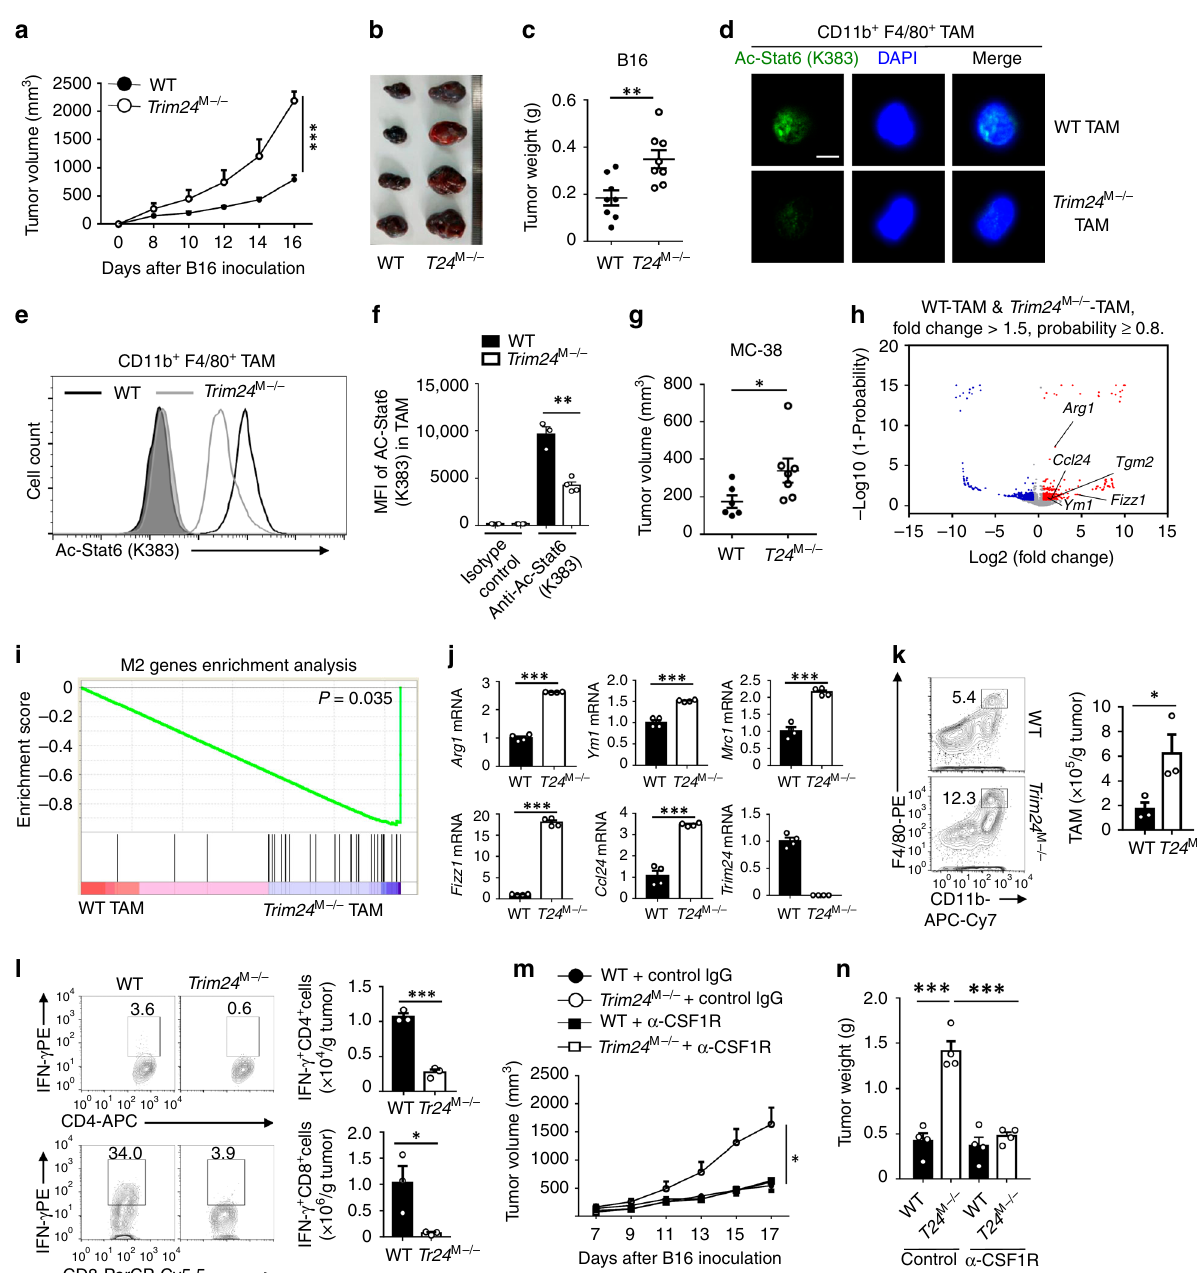
Fig. 7 Trim24 de fi ciency in macrophages impaired antitumor immunity. a – c Tumor growth ( a ), representative tumor pictures ( b ), and tumor weight ( c ) of WT and Trim24 M − / − mice ( n = 8) that were injected s.c. with B16 melanoma cells. d Confocal microscopy images showing Lys383-acetylated Stat6 in the nucleus of tumor-associated macrophages (TAMs) that isolated from B16 melanoma of WT and Trim24 -de fi cient mice; DAPI staining indicated the nucleus of the cells. Scale bars: 5 μ m. e , f Flow cytometric analysis of endogenous Stat6 acetylation at Lys383 in WT and Trim24 -de fi cient TAM as described in ( d ). Data are presented as a representative histogram ( e ) and summary bar graph ( f ). g Tumor weight of WT (n = 6) and Trim24 M − / − mice ( n = 7) that were injected s.c. with MC-38 colon adenocarcinoma cells. h – j RNA-sequencing analysis of gene pro fi les ( h ), M2 gene enrichment ( i ), and QPCR veri fi cation of M2 genes ( j ) in WT and Trim24 M − / − TAM that were isolated from B16 melanoma. The M2 signature genes were indicated in the plot. k , l Flow cytometric analysis of CD45 + CD11b + F4/80 + TAM ( k ) and IFN γ -producing CD4 + and CD8 + T cells ( l ) in B16 melanoma of WT and Trim24 M − / − mice. Data are presented as a representative plot (left panel) and summary graph (right panel). m , n Tumor growth ( m ) and weight ( n ) in WT or Trim24 M − / − mice ( n = 4) that were injected s.c. with B16 melanoma cells, and with intravenous injection of the anti-CSF1R antibody to deplete macrophages in vivo. Data with error bars are represented as mean ± SD. Each panel is a representative experiment of at least three independent biological replicates. ∗ p < 0.05, ∗∗ p < 0.01, ∗∗∗ p < 0.001 as determined by the unpaired Student ’ s t test. Source data are provided as a Source Data fi